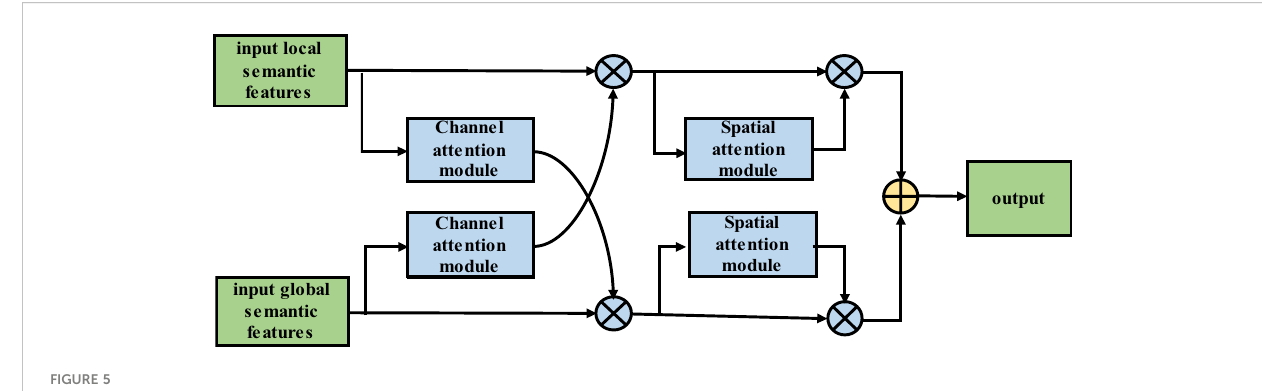
FIGURE 5 Improved two-feature cross-fusion structure